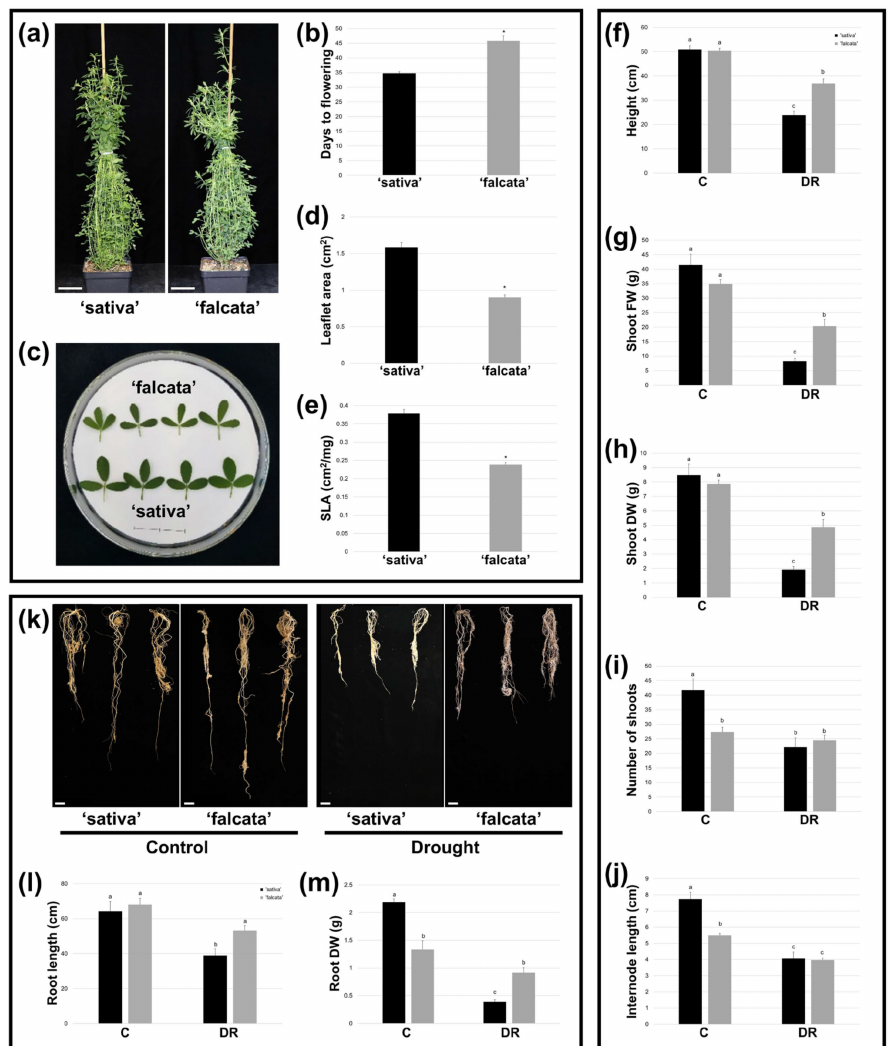
Figure 2. Aboveground and belowground morphological characteristics of ‘sativa’ and ‘falcata’ genotypes grown under well-watered conditions, as well as following drought recovery. ( a ) Representative images of ‘sativa’ and ‘falcata’ taken approximately 1 month following cutting. Scale bars = 5 cm. ( b ) Number of days following cutting until plants flowered under well-watered conditions. ( c ) Representative image of ‘sativa’ and ‘falcata’ trifoliate leaves (third from shoot tip) under well-watered conditions. Scale bar = 4 cm. ( d ) Area of middle leaflet of third fully expanded trifoliate leaf from shoot tip under well-watered conditions. ( e ) Specific leaf area (SLA) of middle leaflet of third trifoliate leaf from shoot tip under well-watered conditions. ( f – j ) Length of the longest shoot, aboveground fresh weight (FW) and dry weight (DW), total number of shoots, and length of the longest internode in ‘sativa’ and ‘falcata’ plants under control conditions (C, approximately 50% soil moisture content) and following drought recovery (DR, 2 weeks of re-watering after allowing soil moisture levels to reach approximately 4%). Measurements were taken 35 ( f – h ) or 37 ( i , j ) days following cutting. ( k ) Representative images of ‘sativa’ and ‘falcata’ roots 54 days following cutting under control conditions (approximately 50% soil moisture content) and following drought recovery (3 weeks of re-watering after allowing soil moisture levels to reach approximately 1%). Scale bars = 5 cm. ( l – m ) Length of the longest root and root DW in ‘sativa’ and ‘falcata’ plants under control conditions (C, approximately 50% soil moisture content) and following drought recovery (DR, approximately 3 weeks of re-watering after allowing soil moisture levels to reach approximately 1% soil moisture content). Measurements were taken 54 days following cutting. For all graphs, blocks consist of the mean value of 5 ( d , e ) or 11 ( f – j , l – m ) biological replicates derived from stem cuttings, with black denoting ‘sativa’ and gray denoting ‘falcata’. Bars denote standard errors. Lowercase letters indicate statistically significant differences between groups in each graph ( p ≤ 0.05), while asterisks denote means that are statistically different in ‘falcata’ compared to ‘sativa’ ( p ≤